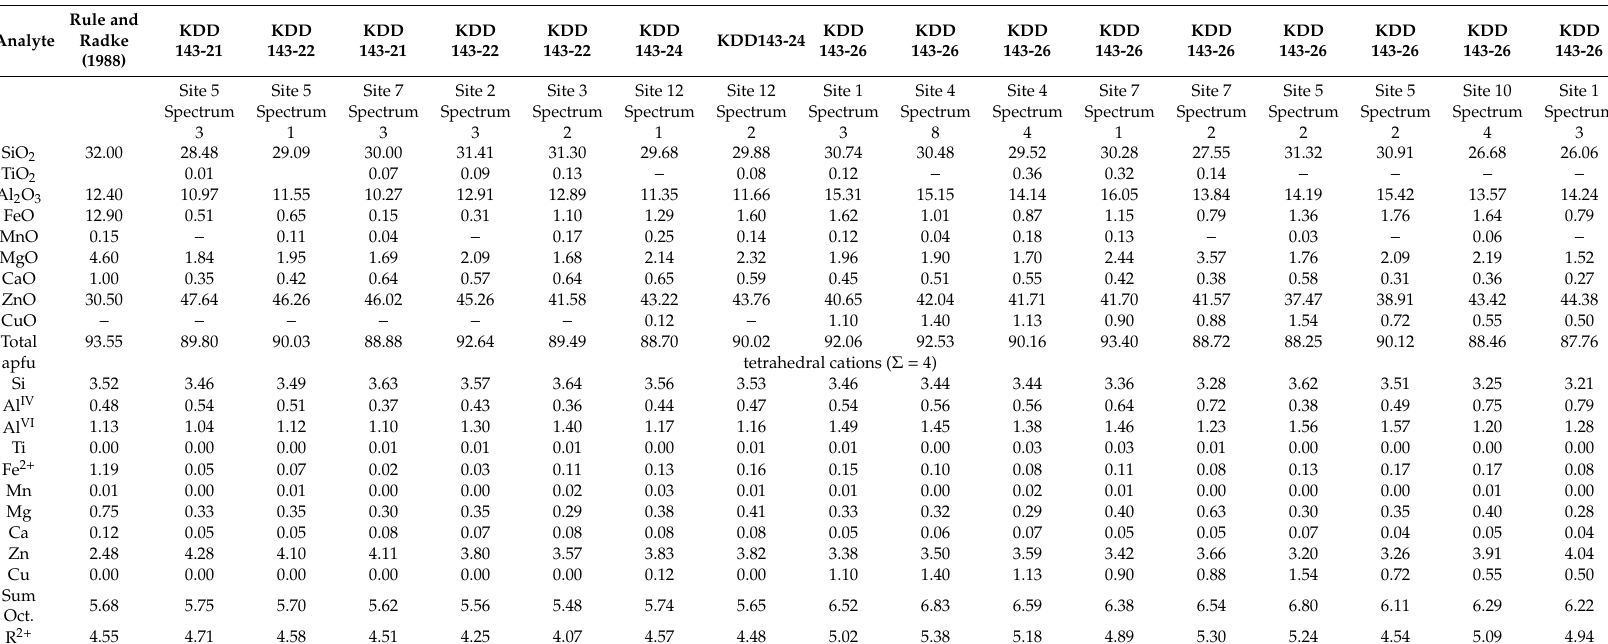
Table A2. Chemical compositions (SEM-EDS) and structural formulae (in atoms per formula units, apfu) of baileychlore from the KDD 143 core. The number of cations are calculated on the basis of O 10 (OH) 8